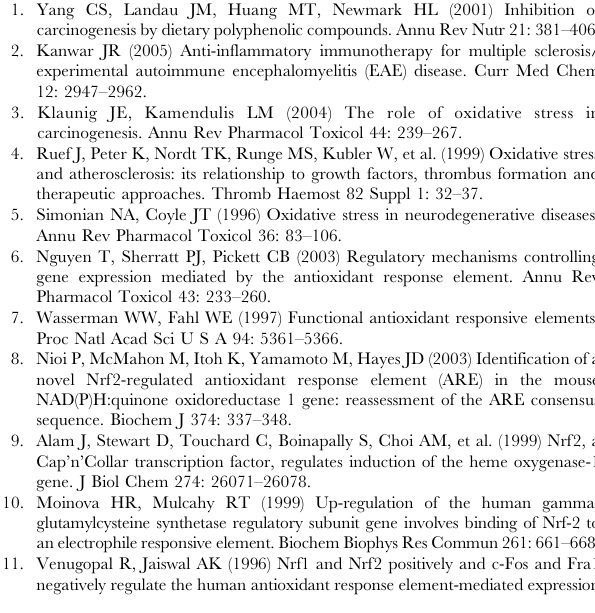
Figure S1 HEK293T cells were co-transfected with expression vectors for HA-Nrf2 wild-type or mutants and different kinases. Cell lysates were collected in denaturing conditions, and phosphorylation analysis was performed as described in Fig. 1A